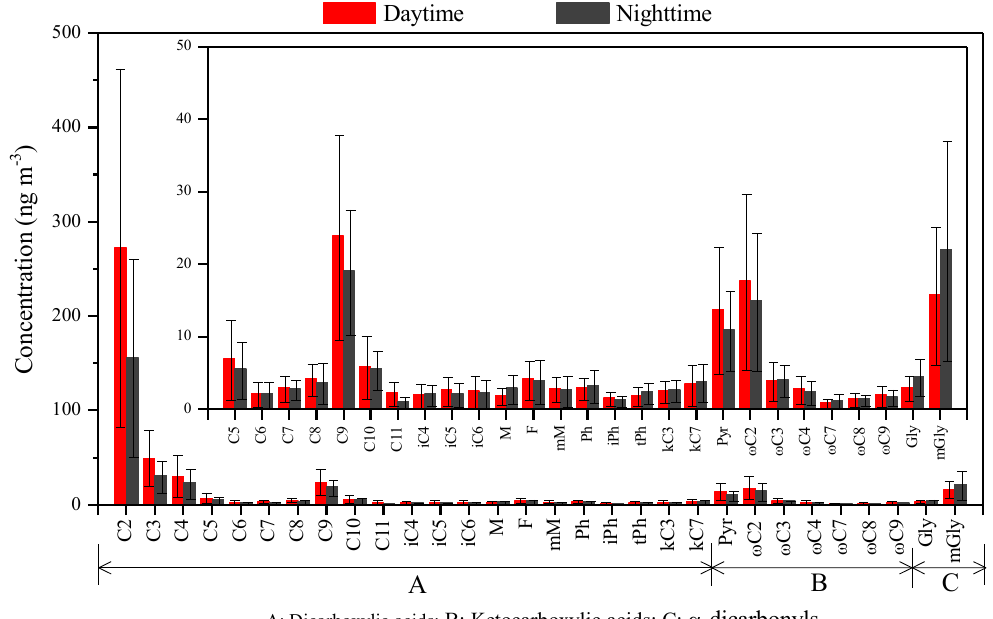
Figure 2. Molecular distributions of dicarboxylic acids and related compounds in PM 2 . 5 of Mt. Tai in the North China Plain.